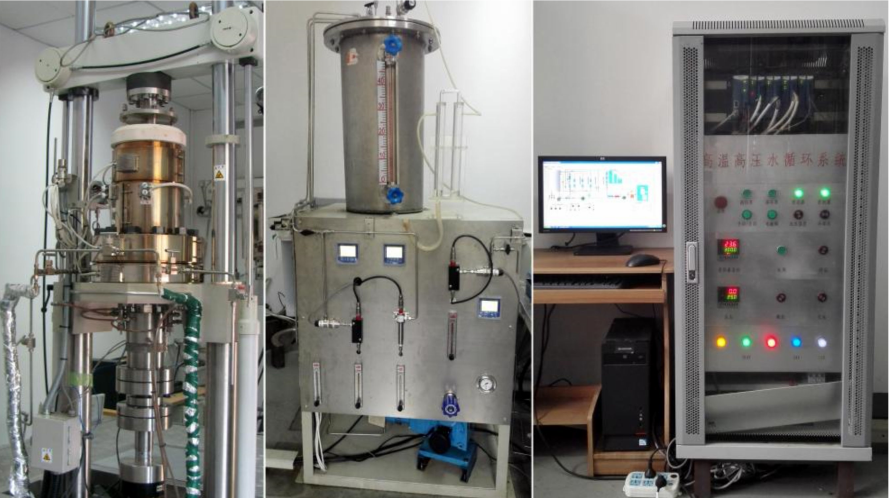
Figure 1. An image showing the instrument setup for a low-cycle fatigue test.